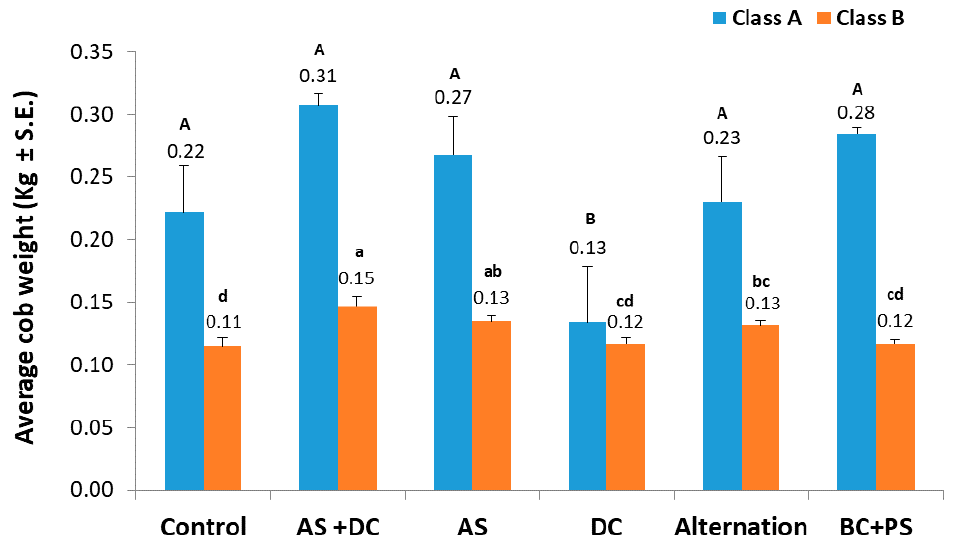
Figure 9. Yield quality (Amir, summer, 2018). The assessment was carried out 21 DAF (76 DAS). The A-class yield classified as cob weight exceeding 250 g. Values represents an average of 10 replications. Upper bars are standard errors. Levels not connected by the same letter (A, B – for the A-class; a, b, c, d – for the B-class) are significantly different ( p < 0.05, ANOVA).